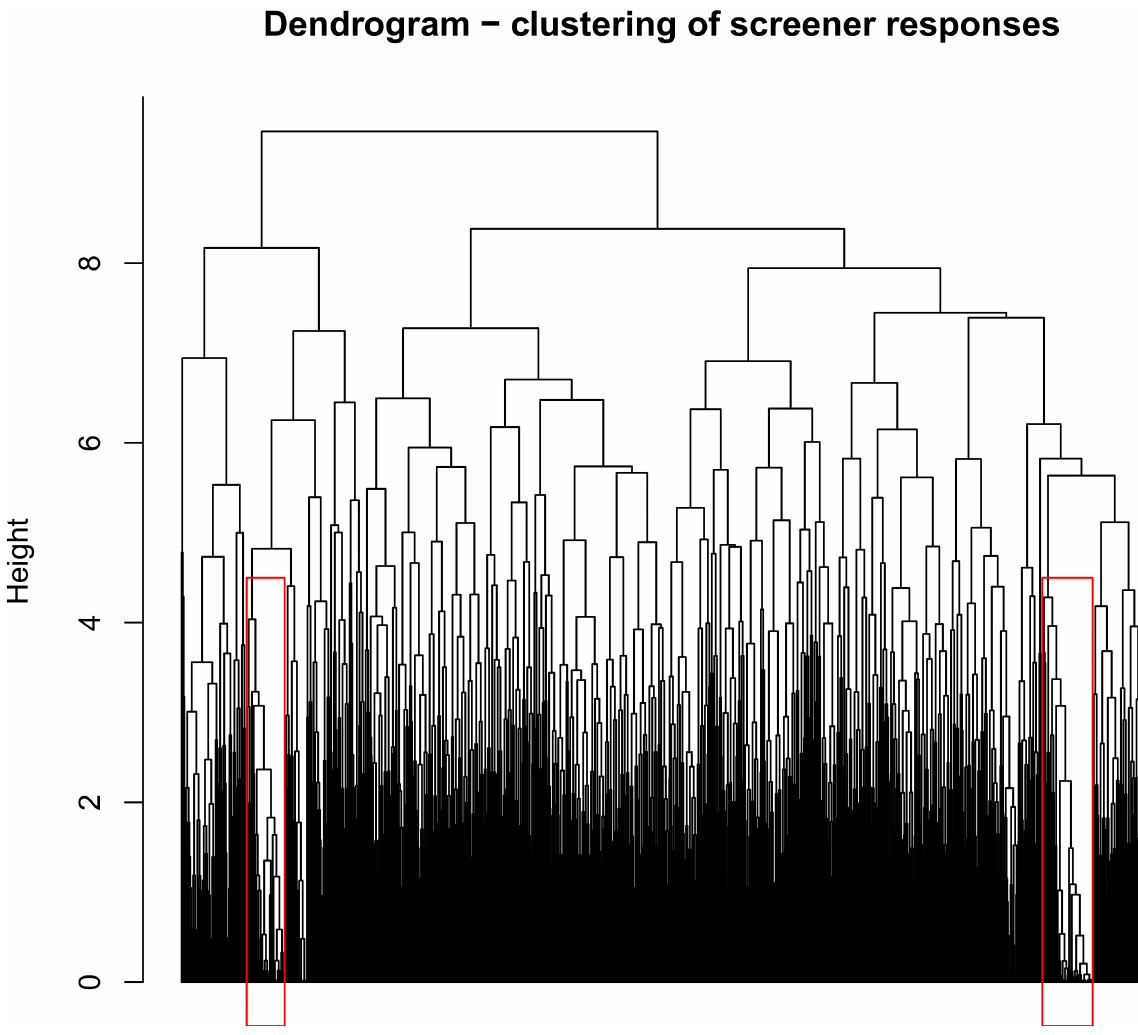
Fig 1. Dendrogram representing clustering of screener responses in participants who went on to complete the baseline questionnaire.